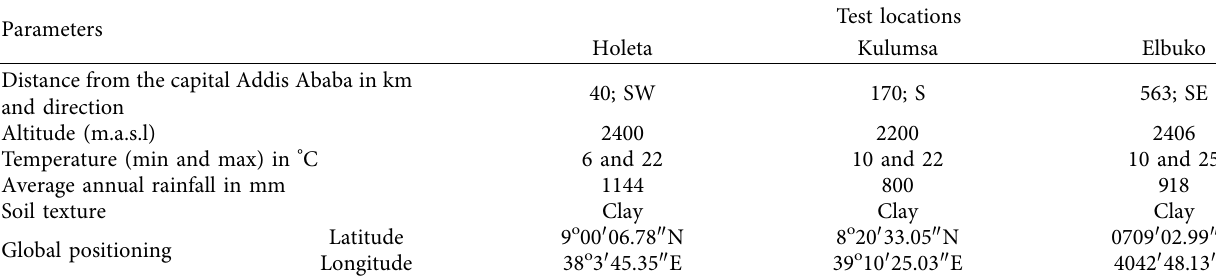
Table 2: Description of the three experiment locations used in the present study.